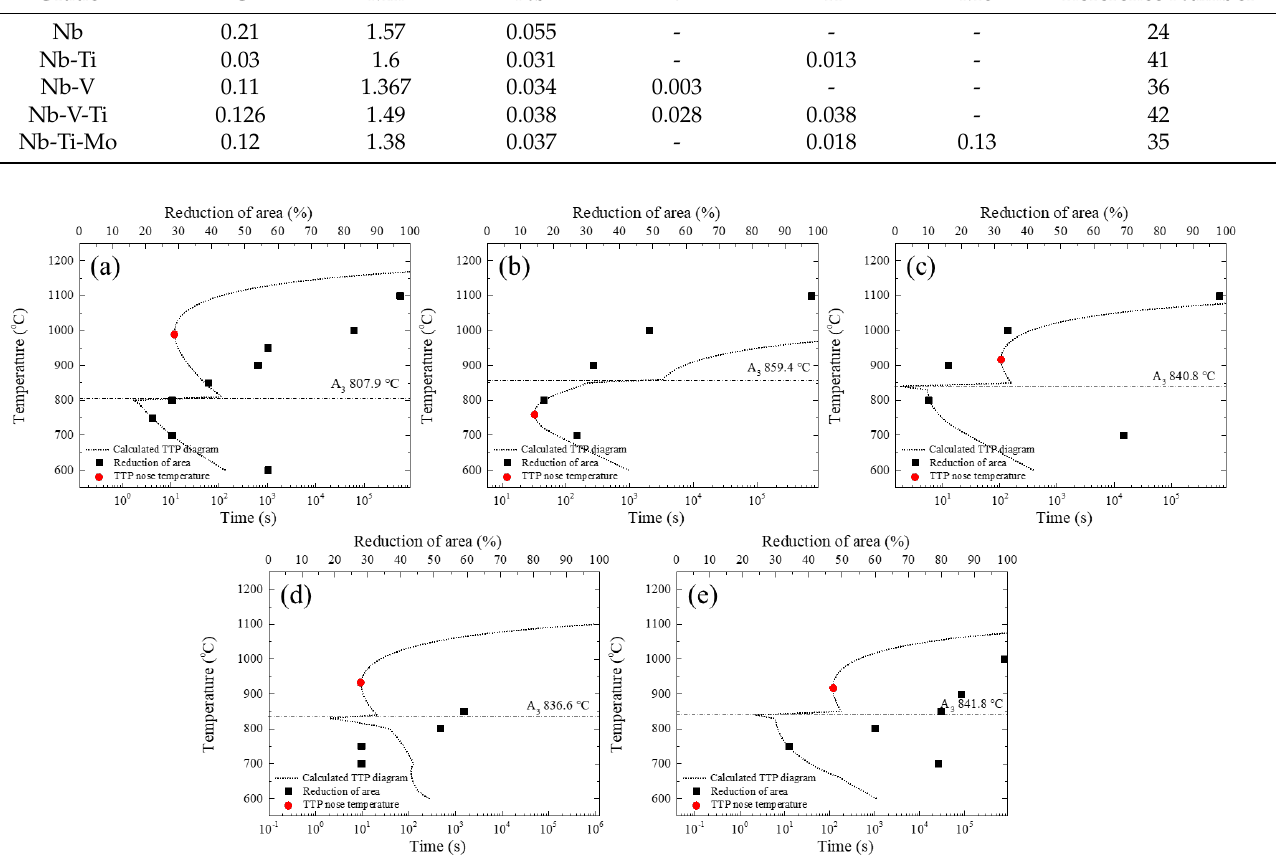
Figure 13. Comparison of model prediction and reduction-of-area results; ( a ) Nb, ( b ) Nb-Ti, ( c ) Nb- V, ( d ) Nb-V-Ti, ( e ) Nb-Ti-Mo; (dashed line: calculated TTP diagram from J-matpro, square point: reduction of area and red dot: TTP nose from prediction model).